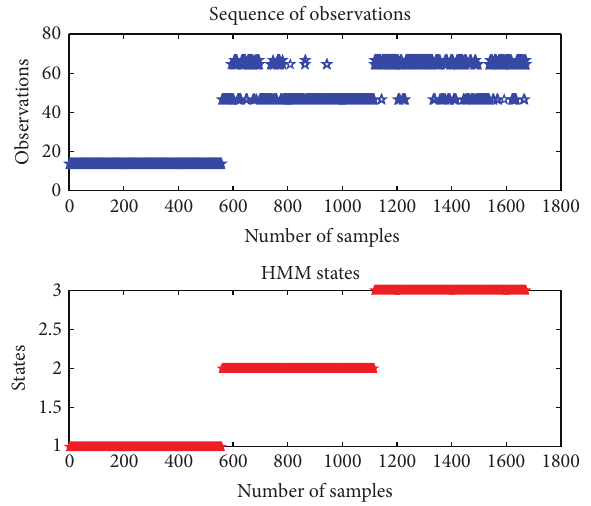
Figure 9: Hidden Markov Model